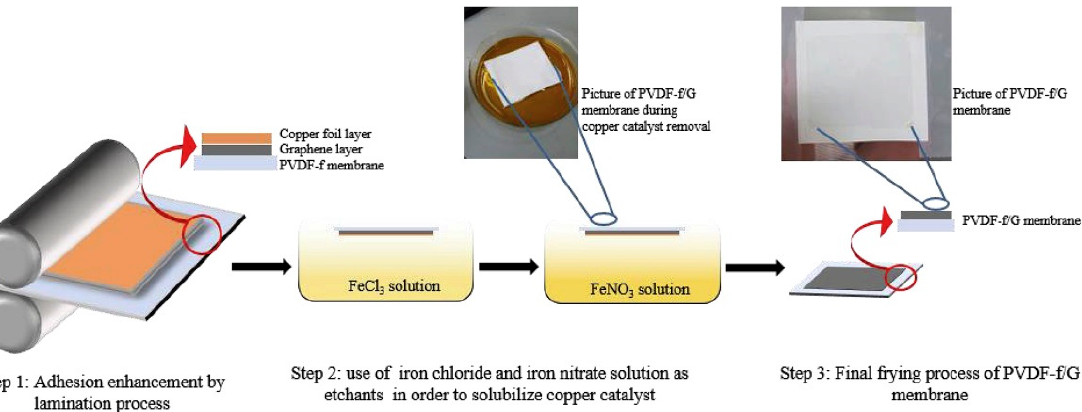
Figure 22. Procedures of grafting graphene on PVDF membrane (grafting) (reused from [93]).